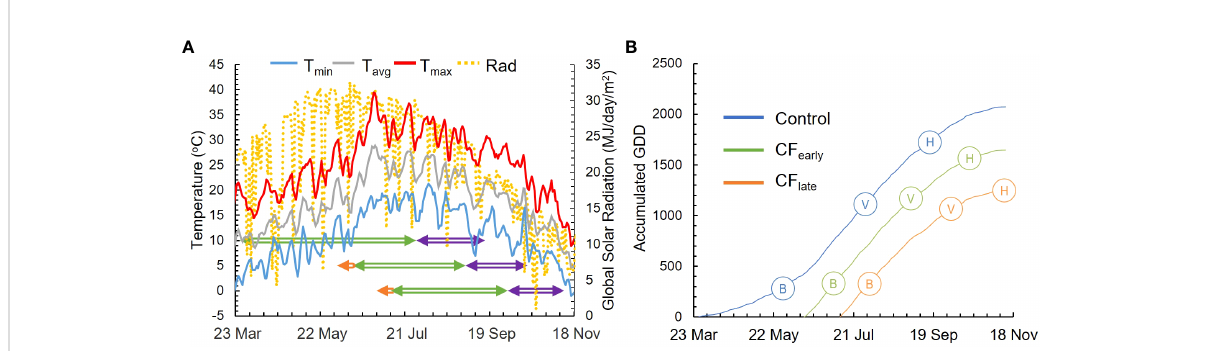
FIGURE 1 Weather and phenological data for season 2019. Daily maximum (red line), mean (grey line), and minimum (blue line) temperatures and daily global solar radiation (dotted yellow line) are represented. Phenological periods represented are from budburst to veraison (green arrowed line) and from veraison to harvest (purple arrowed line). Period from forcing treatment to budburst is also represented (orange arrowed line) (A) . The seasonal cumulative GDD for 2019 season for Control (blue line), CF early (green line) and CF late (orange line) (B) . Full bloom (B), veraison (V) and harvest (H) are also